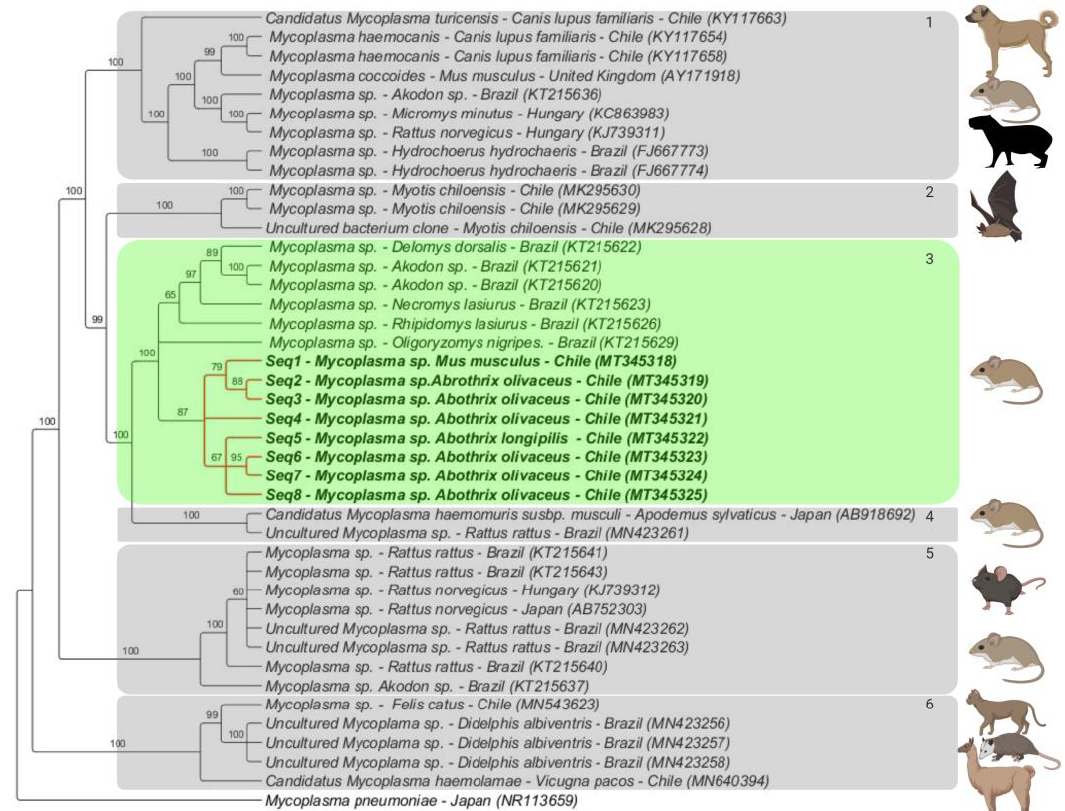
Figure 2. Phylogenetic tree based on an alignment of sequences of hemotrophic Mycoplasma spp. 16S rDNA (800 bp) sequences, using the Bayesian method and the TIM3 + I + G evolutionary model. Numbers at nodes correspond to posterior probability values. Sequences detected in the present study are bolded. Mycoplasma pneumoniae was used as an outgroup.